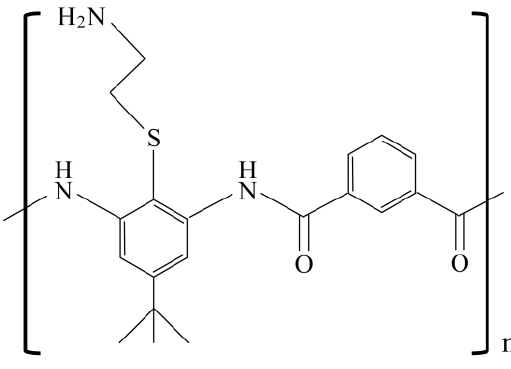
Figure 3. Representative structure of arylamide polymers. The diamine was used for convenience of synthesis and its conformational properties. The thioether was chosen with the expectation that hydrogen bonding to both the amide protons would stiffen the